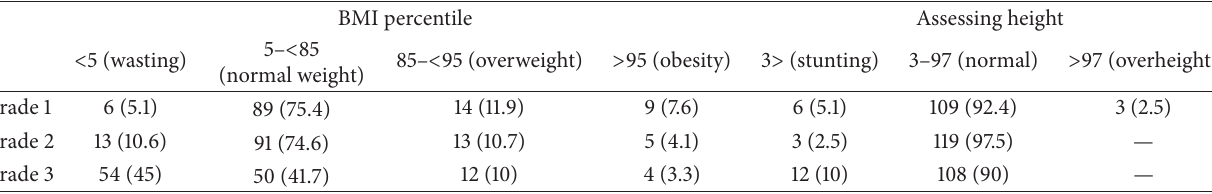
Table 3: Distribution of stunting, wasting, obesity, and overweight in different educational levels.